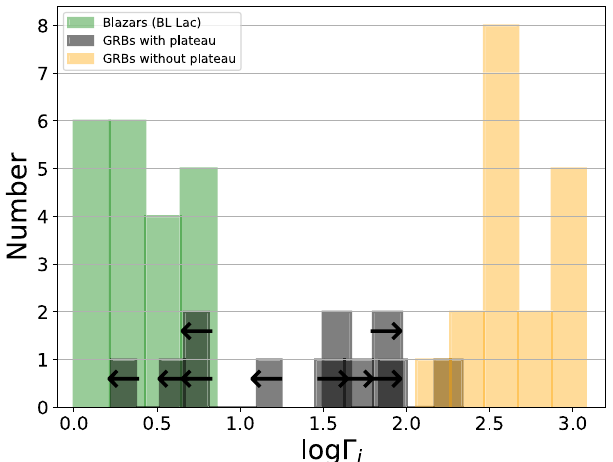
Fig. 7 | Histogram of the initial jet Lorentz factors. Black represents the GRBs in oursample,astheyappearinFig.5.YellowrepresentsGRBsobservedbytheFermi- LAT instrument, taken from Ref. 3, whose jet Lorentz factor is deduced from the opacity argument (GRBs 090926A, 090902B, 090510, 080916C; see Ref. 3, fi gure 11) and other GRBs that do not show a plateau phase (except GRBs 050319 and 061021), taken from Ref. 51 (table 6 therein). Green represents the inferred lower limit to the Lorentz factor of BL Lac objects (Blazars), taken from Ref. 72 (see their table 2A). The values of the Lorentz factor we found, of few tens, fi lls the gap